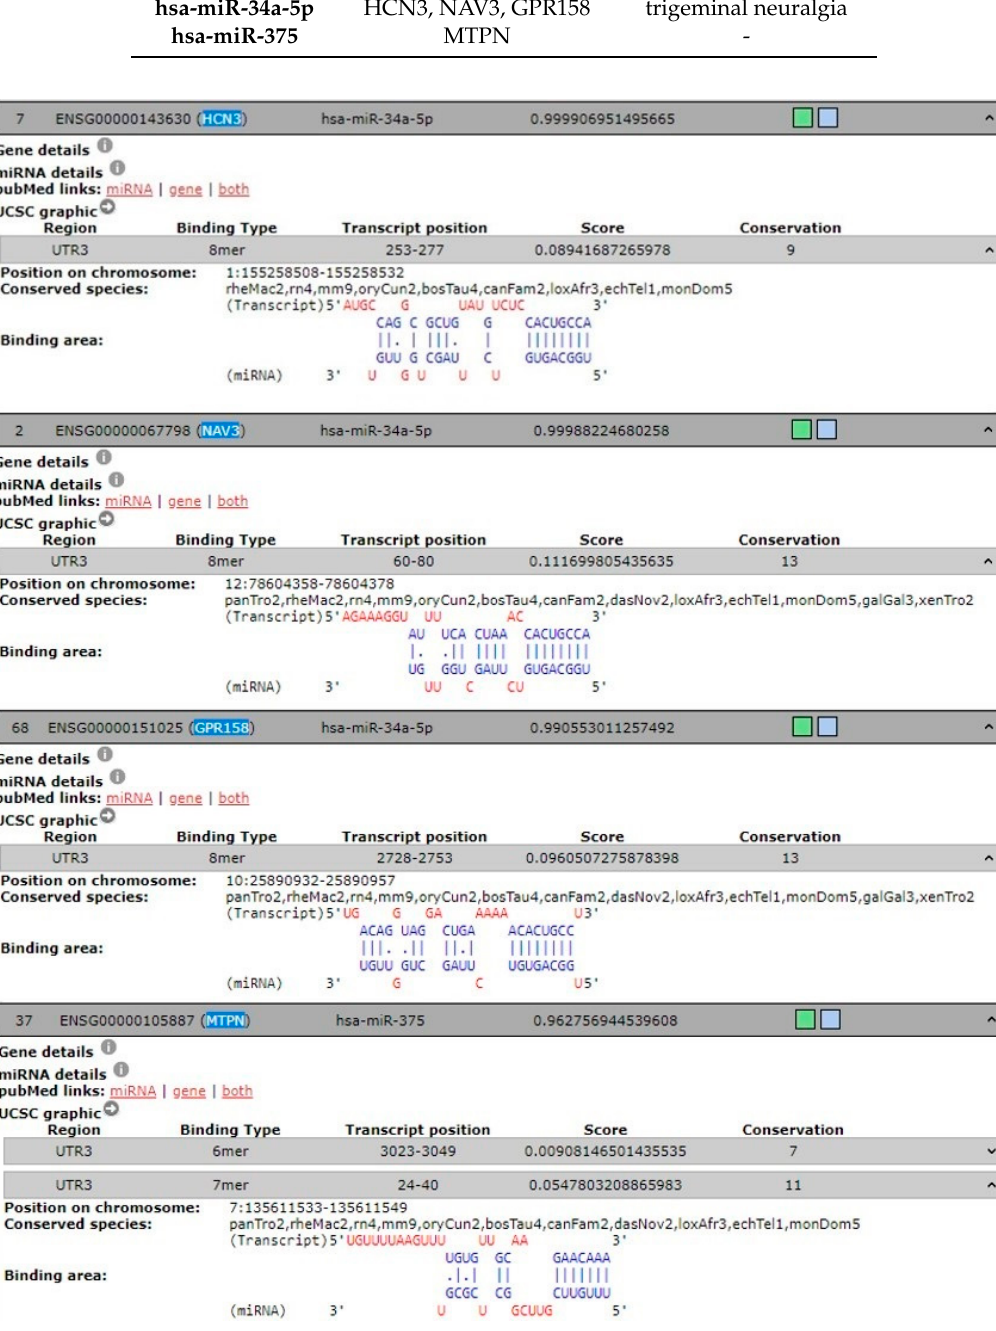
Figure 3. Predicted and experimentally validated interaction of hsa-miR-34a-5p and hsa-miR-375 (both in blue) with the corresponded 3’UTR mRNA genes (in red) from DIANA-TOOLS database.